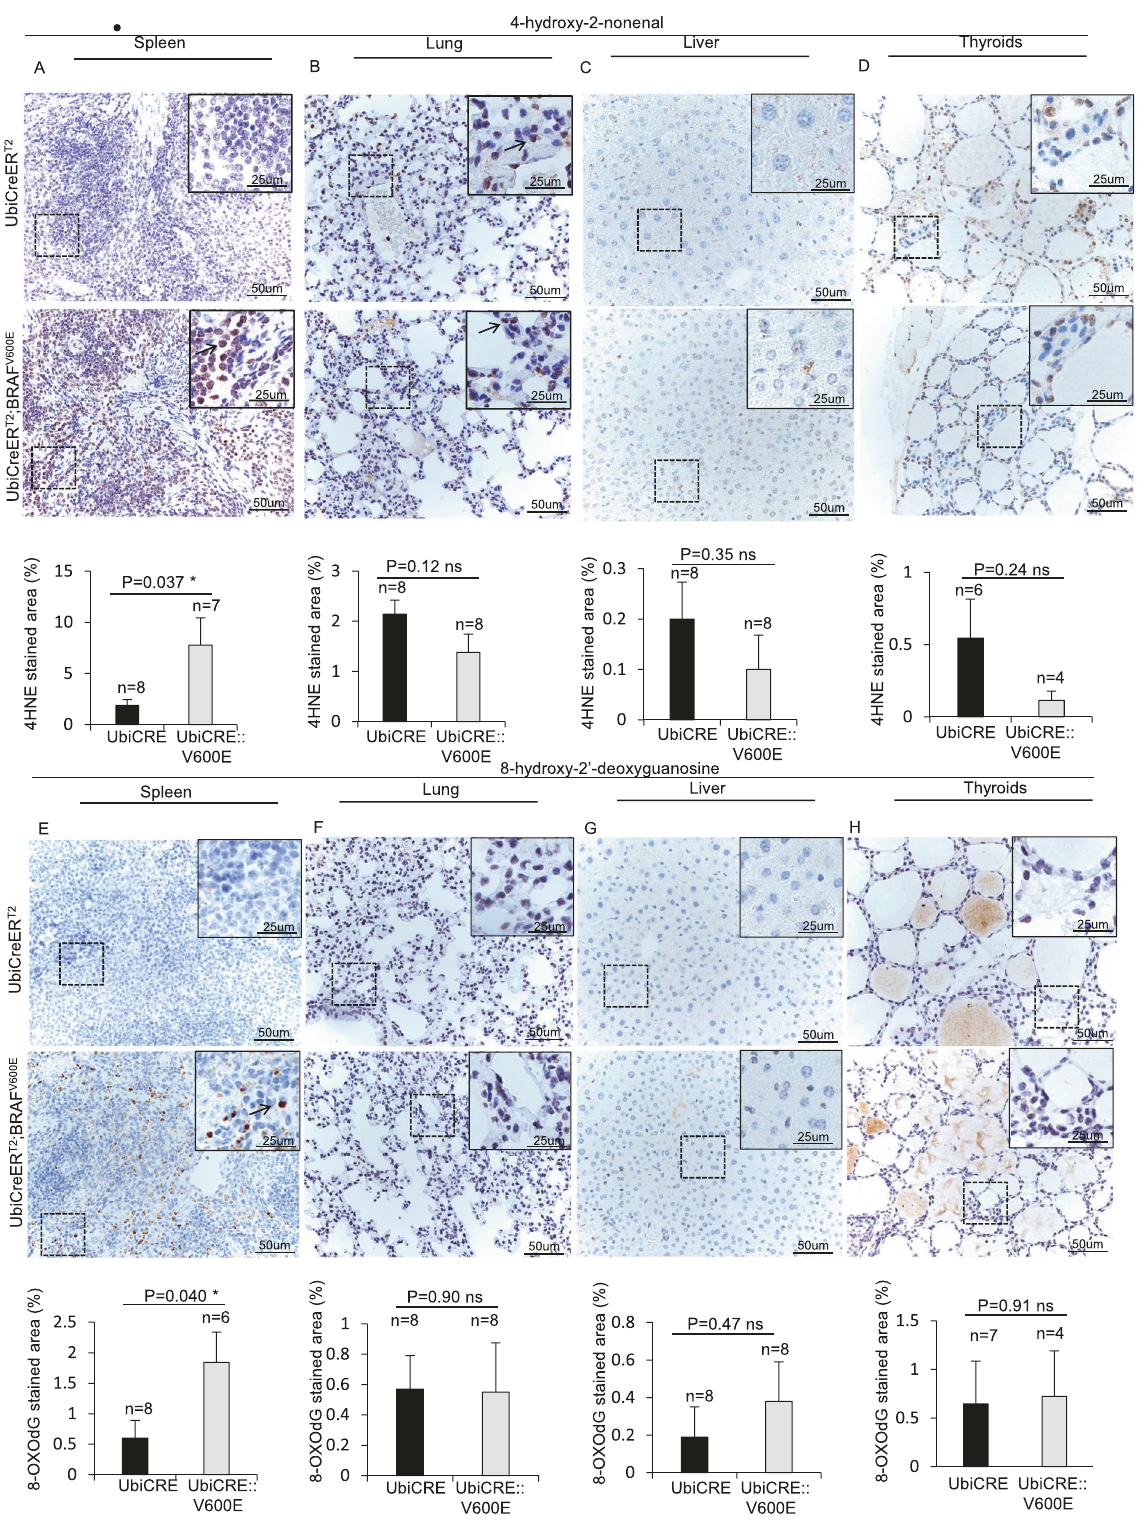
Fig. 8 BRAF V600E induction results in ROS generation in the spleen but not in the lungs, liver or thyroids. Representative images (top) and quanti fi cations (bottom) showing stainings positive for A – D 4-hydroxy-2-nonenal and E – H 8-hydroxy-2 ’ -deoxyguanosine respectively in spleen ( A, E ), lung ( B, F ), liver ( C, G ) and thyroids ( D, H ) sections from BRAF V600E and control mice. Quanti fi cations were performed on at least fi ve different areas of tissue sections in a random way. Data are expressed as mean ± SEM; n = animals per group. * P < 0.05; ** P < 0.01; *** P < 0.001, ns = not signi fi cant. (T Student ’ s test unpaired). Arrows point to selected positive cells for the indicated marker. Insets: magni fi cations of areas inside dashed squares.